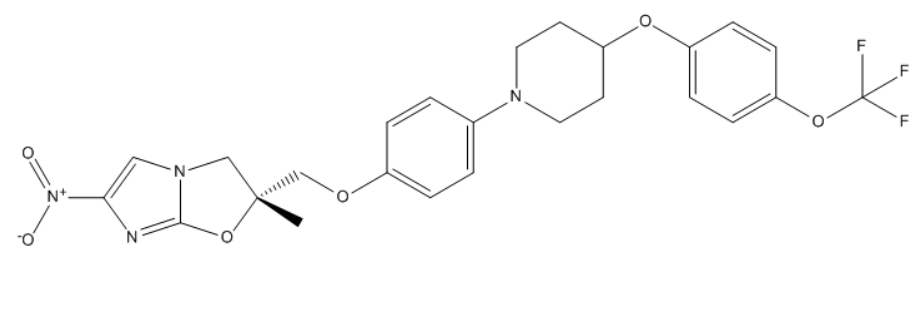
Figure 2. Structure of